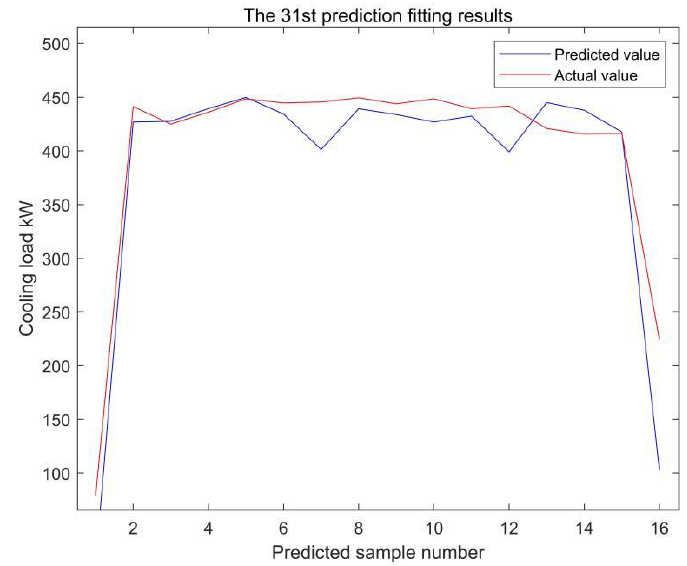
Figure 37. The fitting effect of the prediction set for August 31 predicted 24 h in advance. errors below 60 kW, 1 sample from 60 kW to 100 kW, and only 1 sample above 100 kW, indicating that the absolute errors are within the acceptable range.